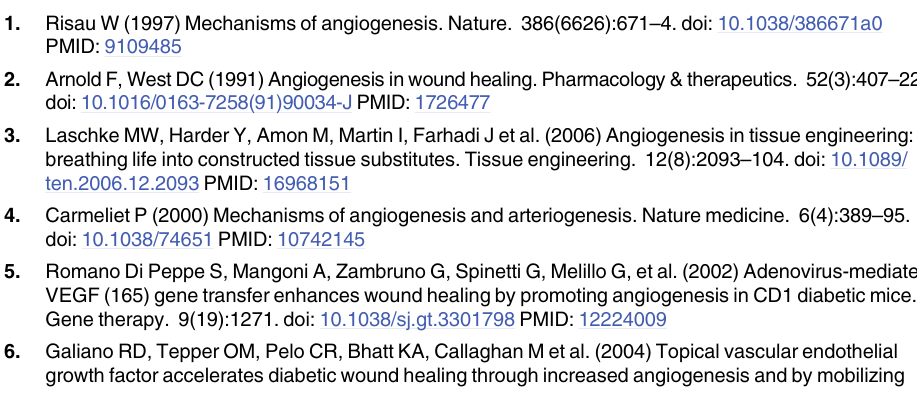
S1 Table. Spreadsheet of 1689 genes identified with significantly altered expression after in- jury derived from Qlucore whole genome microarray analysis. S2 Table. Characteristics of genes related to angiogenesis identified by microarray studies. S1 Fig. Characteristic changes in macroscopic appearance of wounds in each treatment group at successive time points. All images in this figure are derived from the same patient. CG — collagen-GAG scaffold, DCD — decellularised dermis. Scale bar is identical in each